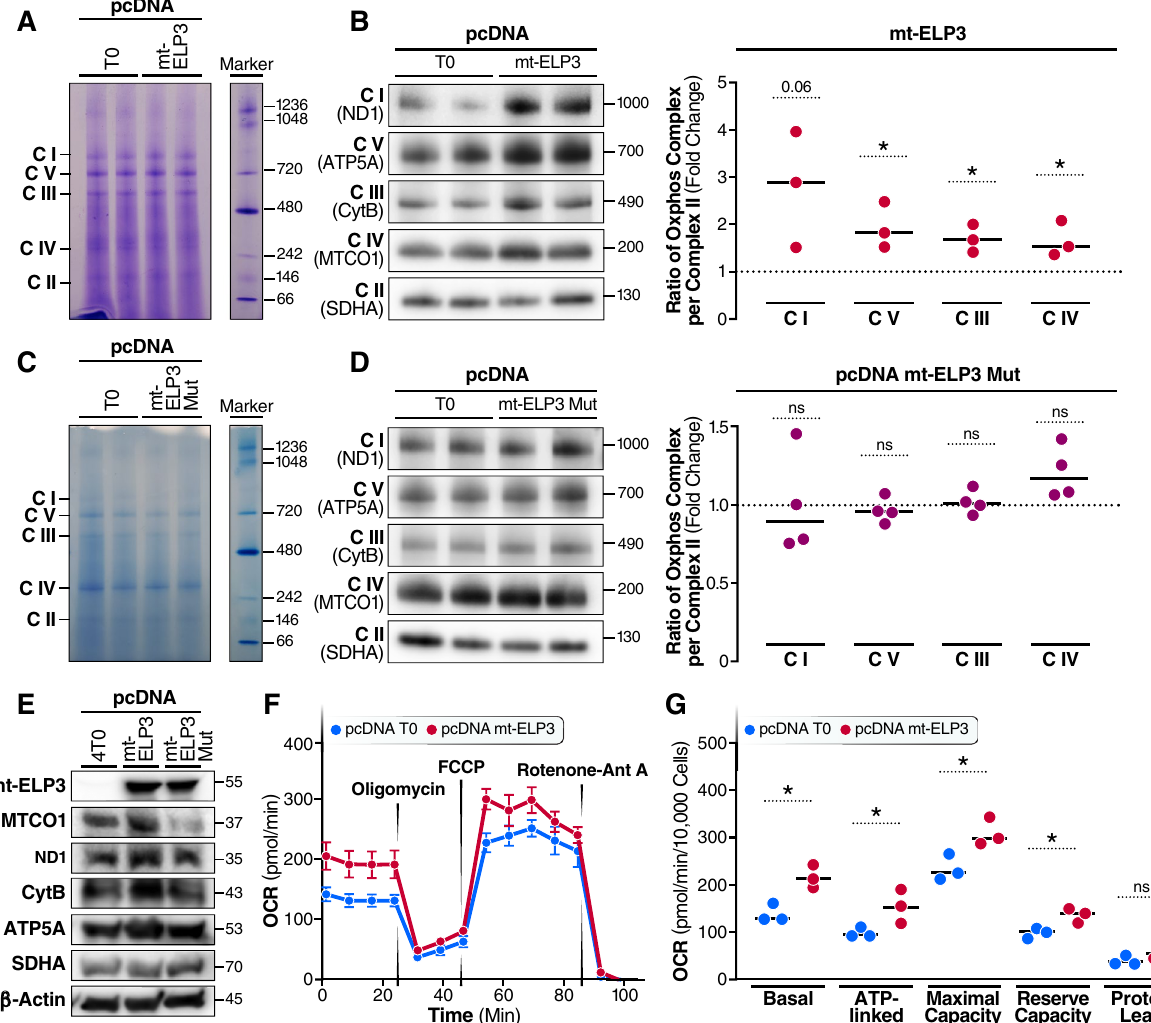
Figure 5. Overexpression of mt-ELP3 results in an increase in the expression of mitochondrial OXPHOS complexes and mitochondrial respiration. ( A ) and ( C ) Representative BN-PAGE gel stained with Coomassie Brilliant Blue of respiratory complexes purified from control cells (pcDNA T0) and cells overexpressing mt-ELP3 (pcDNA mt-ELP3) ( A ), and from control cells (pcDNA T0) and cells overexpressing mt-ELP3 mutant (pcDNA mt-ELP3 mut) ( C ). A 20-µg aliquot of each sample was loaded per well. A 5-µL aliquot of NativeMark unstained protein standard (Marker) was loaded. ( B ) and ( D ) Representative Blue Native-PAGE of OXPHOS complexes in HEK293T cells transfected with pcDNA4 T0 or pcDNA mt-ELP3 ( B ) and with pcDNA4 T0 or pcDNA mt-ELP3 mut ( D ). The scatter plots show the densitometric measurements of OXPHOS complexes normalized to complex-II (loading control) and represented as fold change relative to control cells. ( E ) Representative immunoblots of mitochondrial OXPHOS subunits ND1 (Complex I), MTCO1 (Complex IV), CytB (Complex III), ATP5A (Complex V) and SDHA (Complex II) in HEK293T cells transfected with pcDNA4 T0, pcDNA mt-ELP3 or pcDNA- mt-ELP3 mut. The membranes were also probed with an antibody against ELP3 and b-actin, B-actin was used as a loading control. ( F ) and ( G ) Oxygen consumption rate (OCR). Equal numbers of HEK293T cells transiently transfected with pcDNA T0 or pcDNA mt-ELP3 were subjected to oxygen consumption measurements in a Seahorse XF96 extracellular flux analyzer, with sequential additions of the metabolic inhibitors/activators: oligomycin, FCCP, antimycin A (Ant A) and rotenone ( F ) The scatter plot shows basal OCR (determined as the difference between OCR before oligomycin and OCR after rotenone/antimycin A/rotenone), ATP-linked OCR (difference between OCR before and after oligomycin), maximal OCR, reserve capacity (difference between the FCCP-stimulated rate and basal OCR) and proton leak (difference between basal OCR and ATP-linked OCR) in pcDNA T0 and pcDNA mt-ELP3 cells ( G ). All data are mean ± SD of at least three different experiments. * p < 0.05, ** p < 0.01. n.s.: not